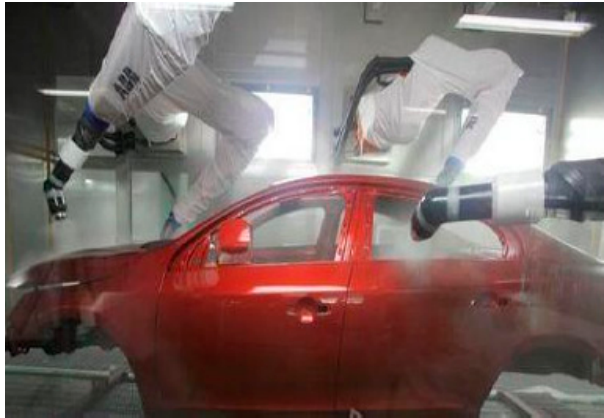
Figure 16. The robotic spray painting experiment.